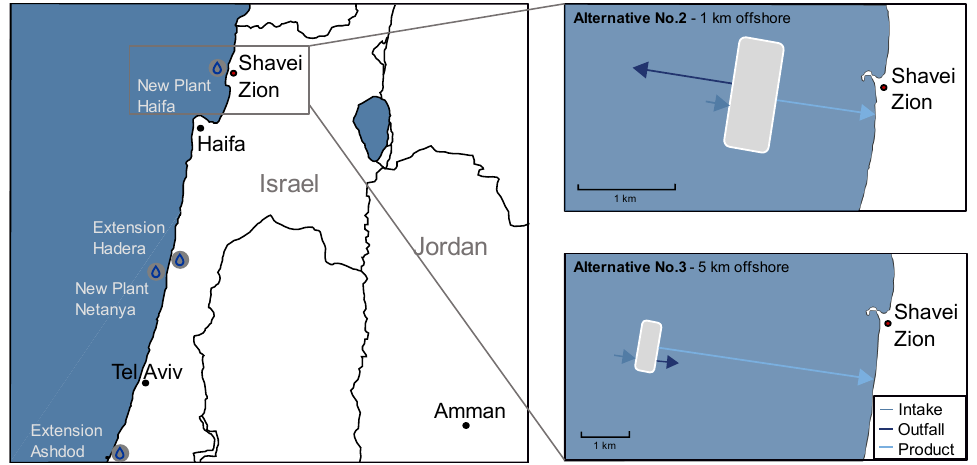
Figure 1. Map of the region including the considered areas for new desalination plants investigated in the SALAM initiative and a zoom-in on the study relevant alternatives No. 2 and No. 3 next to Shavei Zion.